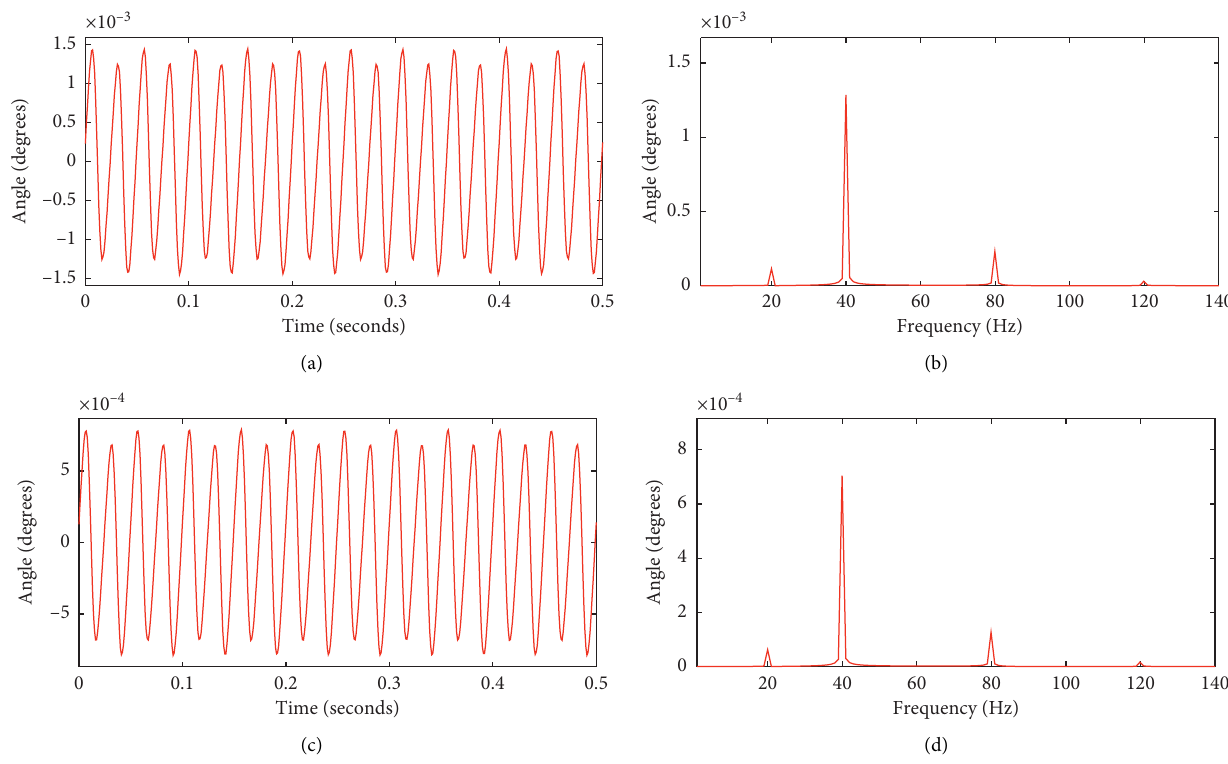
Figure 16: Time- and frequency-domain responses to the combined effects of imbalance and angular misalignment in the angular directions and θ . (a) Time response of θ θ 1 2